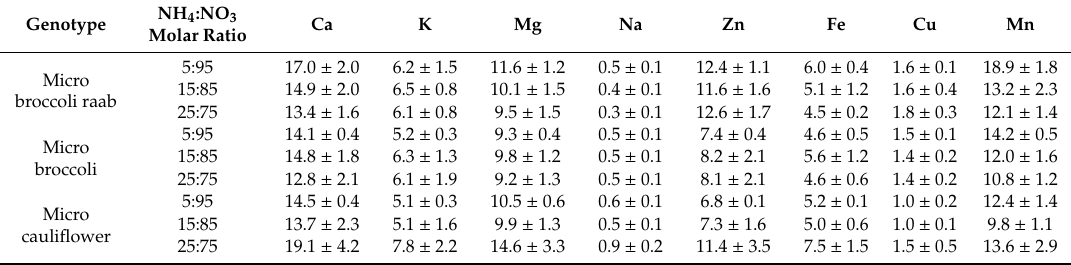
Table 5. Percent of nutritional contribution ( ± standard deviation) of mineral elements per serving size of Brassica microgreens based on the Dietary Reference Values.